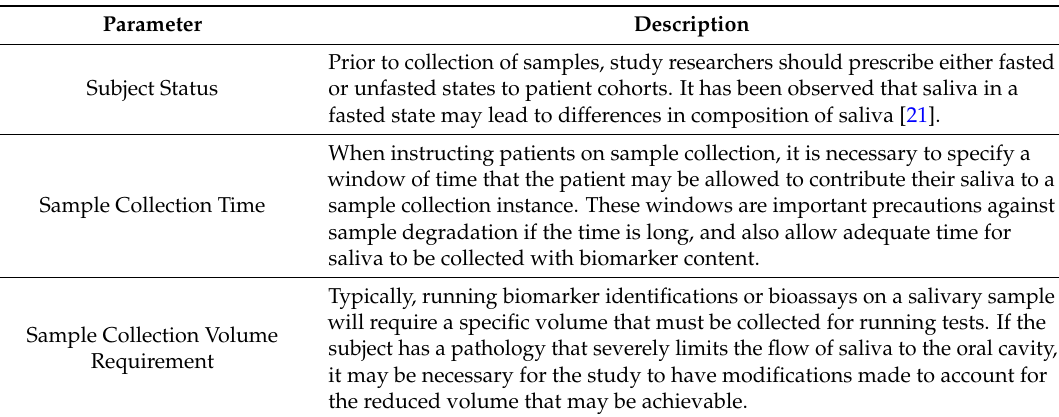
Table 1. Considerations regarding the collection and sample processing steps of